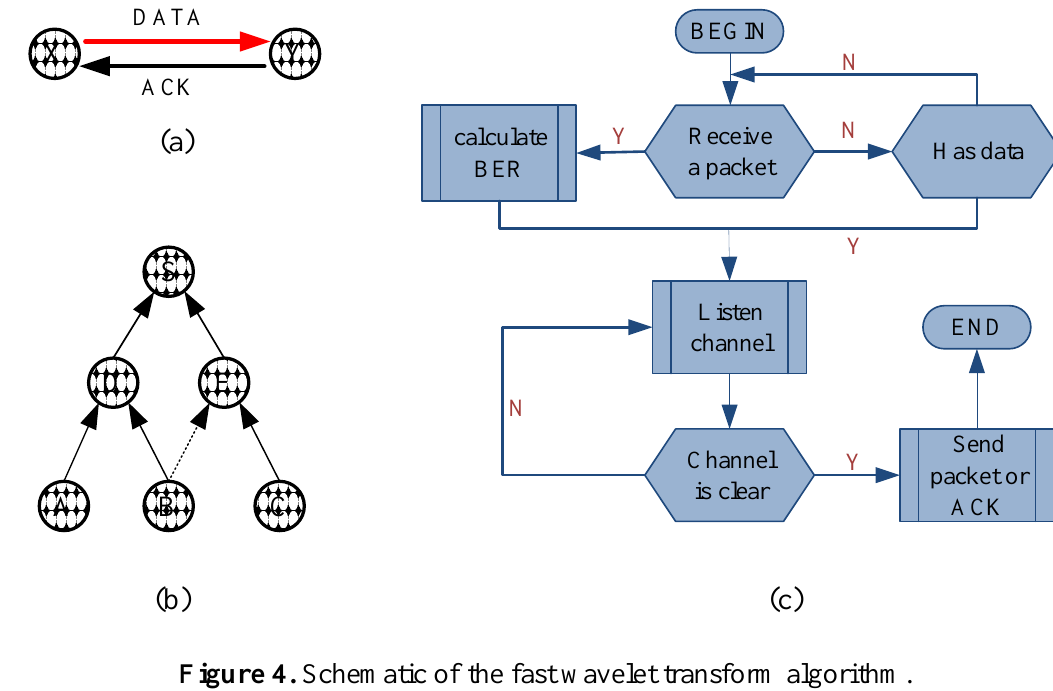
Figure 3. Routing algorithm for the wireless corrosion monitoring network.